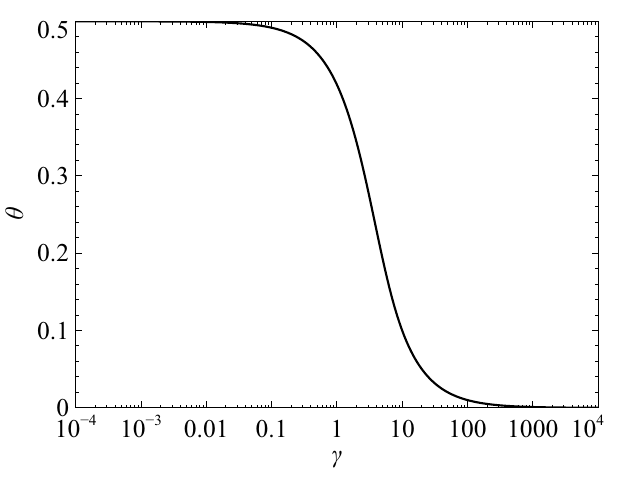
Figure 2. Relation of γ and θ .